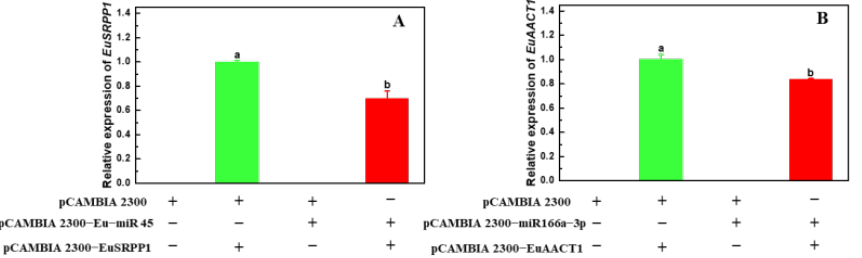
Figure 6. Validation of the predicted miRNA − target gene pairs using the transient co − expression assays in N. benthamiana leaves ( A , B ). The expression levels were quantified using RT − qPCR. Bars indicate means ± SE (n = 3). Different letters on the error bars indicate significant differences.